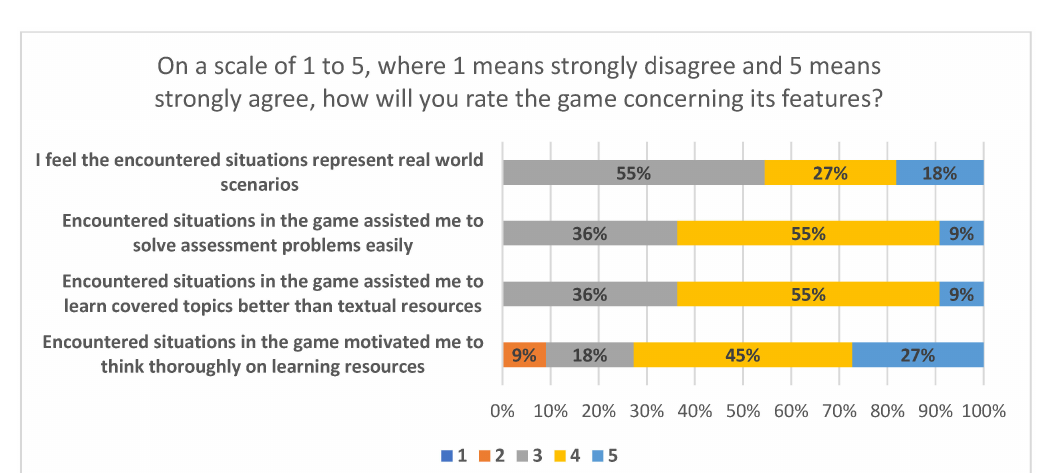
Figure 13. Respondents’ rating concerning the game’s situations (i.e., content).